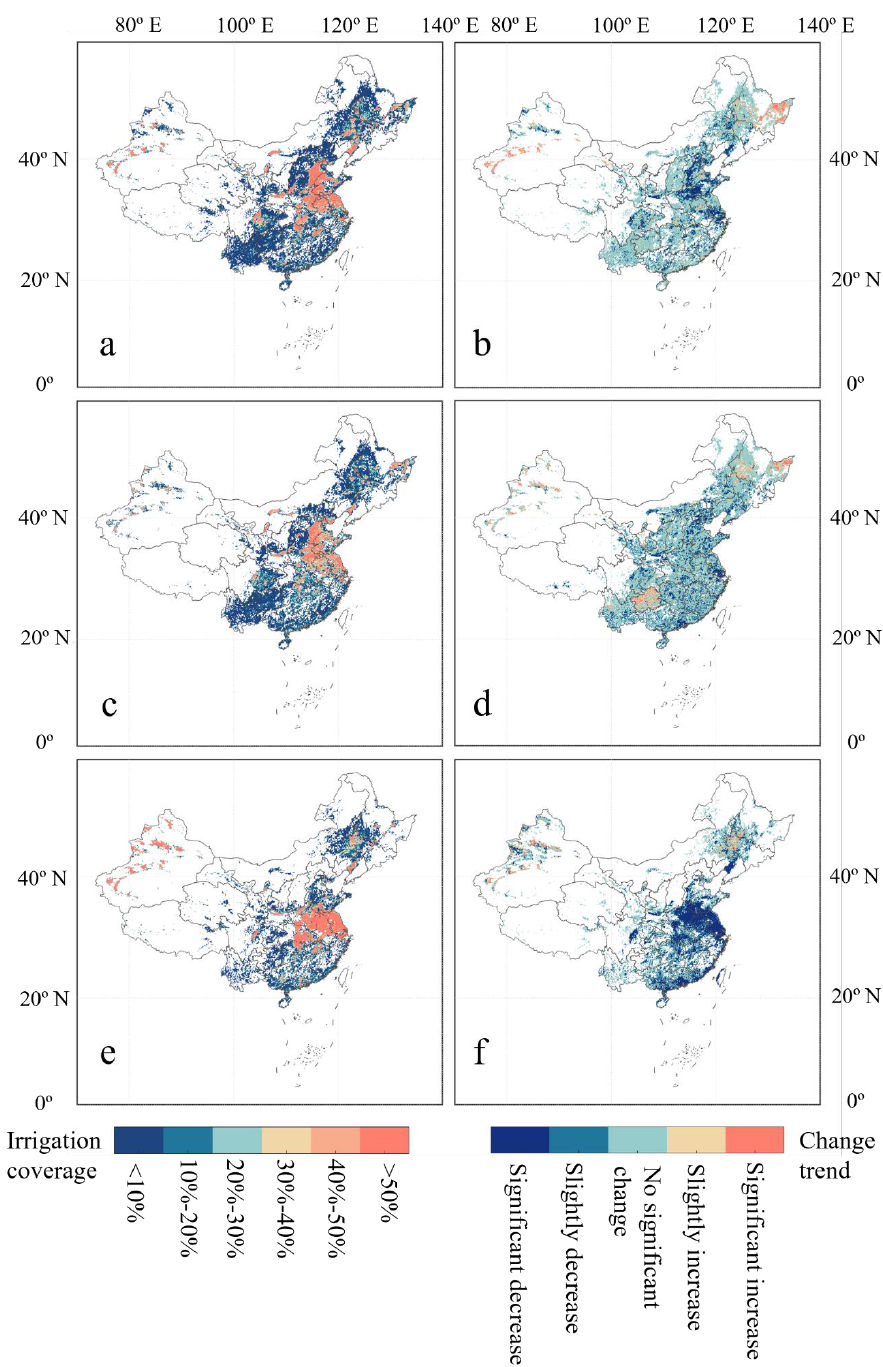
Figure 6. The average coverage ( a – e ) and change trend ( b – f ) of irrigated cropland during 2000–2019 in mainland China derived from this study ( a , b ), Irrimap-Syn ( c , d ), and CCI-LC ( e , f ) at 5 arcmin resolution.